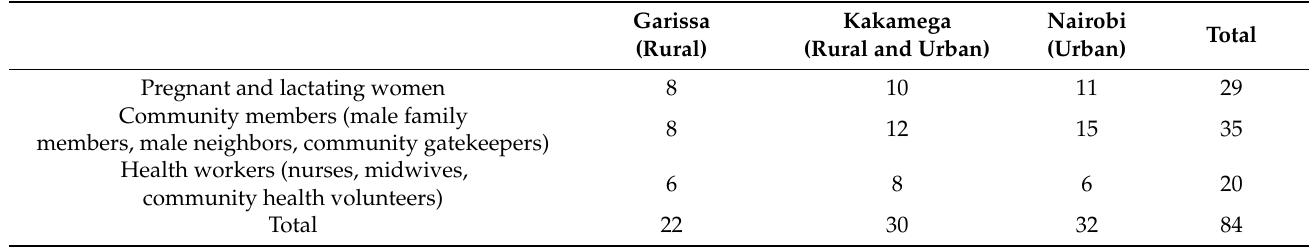
Table 1. Participants by audience type and location.